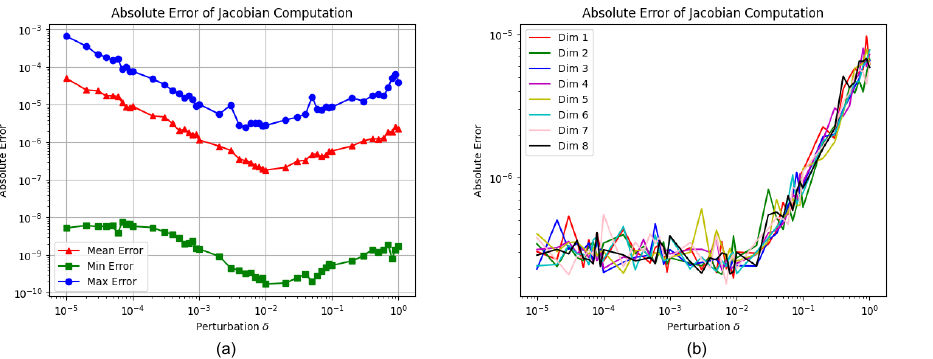
Figure 6. The absolute error of Jacobian computation between the proposed numerical method and auto-gradient functions in the deep learning library. ( a ) Comparison of the results with the proposed method and deep libraries by varying the perturbation δ from 1.0 − 2 to 1.0; ( b ) absolute Jacobian error for a certain dimension by varying the δ from 1.0 − 2 to 1.0, while fixing the δ for other